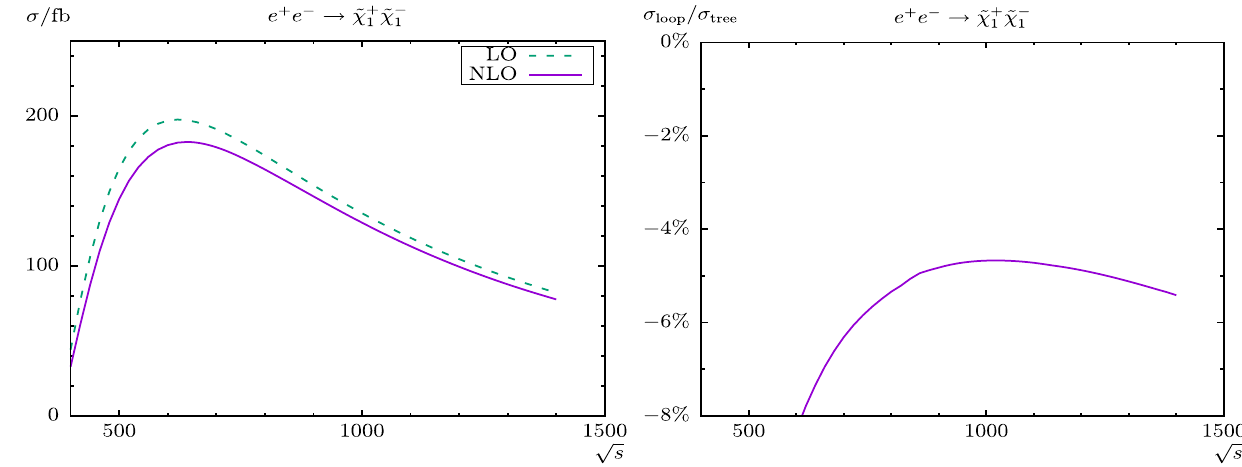
√ s (in GeV) varied